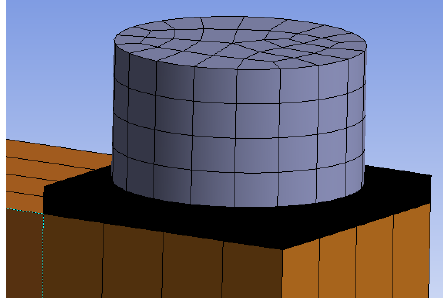
Figure 13. Finite ‐ element mesh for applying load.